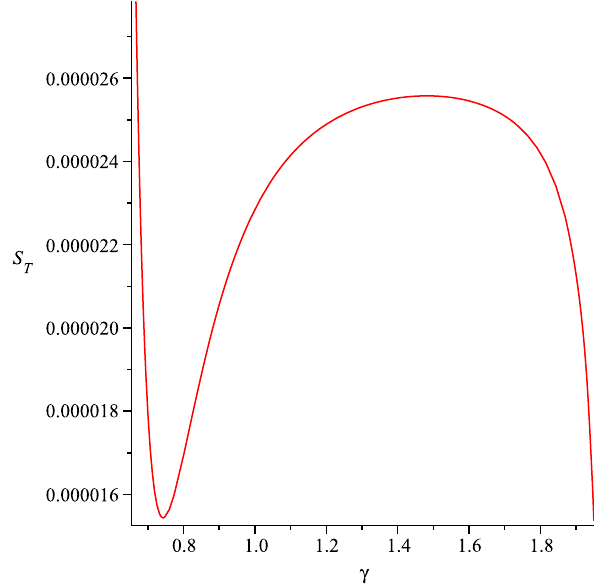
Fig. 1 The total entropy S T for allowed values of γ , taking H = 67 and T 0 = 10